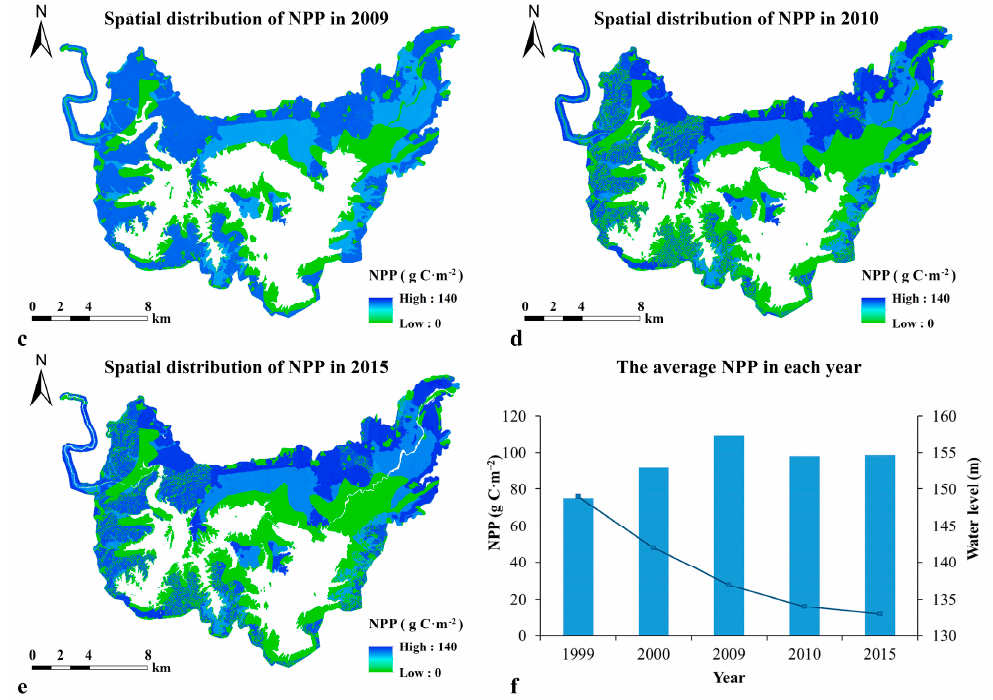
Figure 4. Spatial distribution of NPP in Miyun’s inner protection zone during different years.